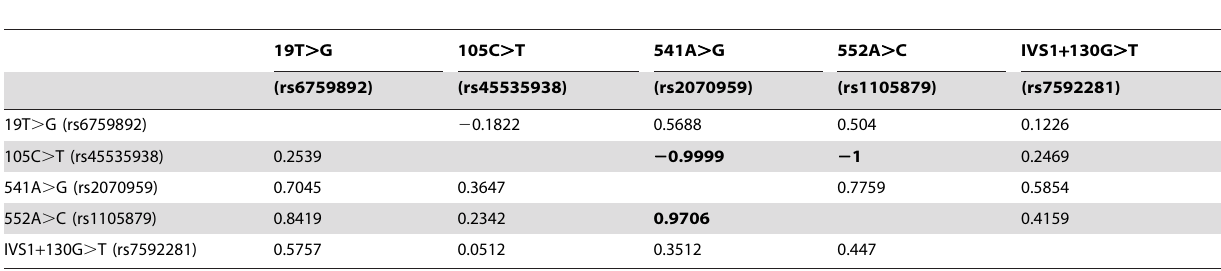
Table 4. Analysis of pairwise linkage disequilibrium (LD) coefficients and statistics (D 9 ) for lung cancer patients (below diagonal) and control (above diagonal) among five SNPs.